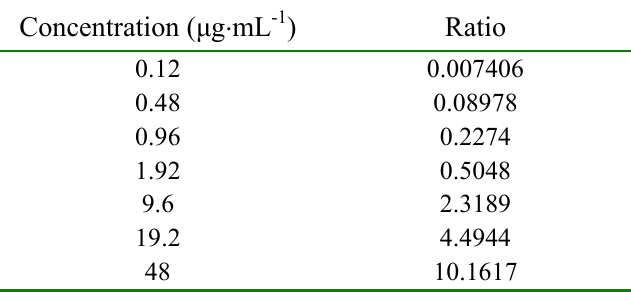
Table 4. Chlorzoxazone Calibration Curve Data.